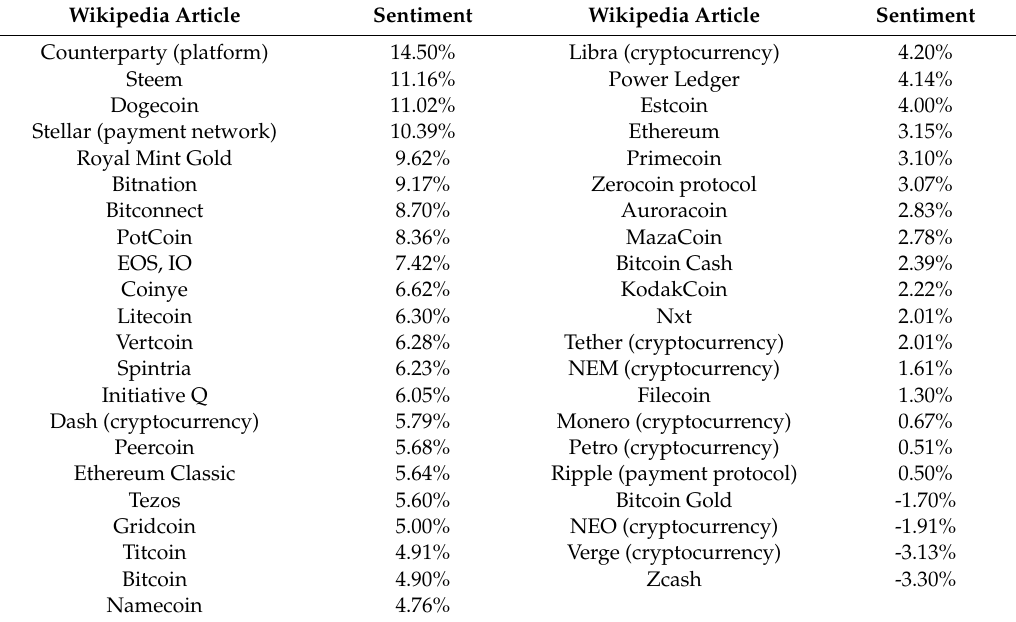
Table 5. Sentiment analysis results for English Wikipedia articles on